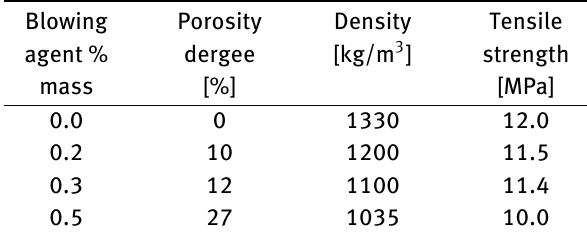
Table 1: Results of the study of selected mechanical properties of cable coat modified by the blowing agent.